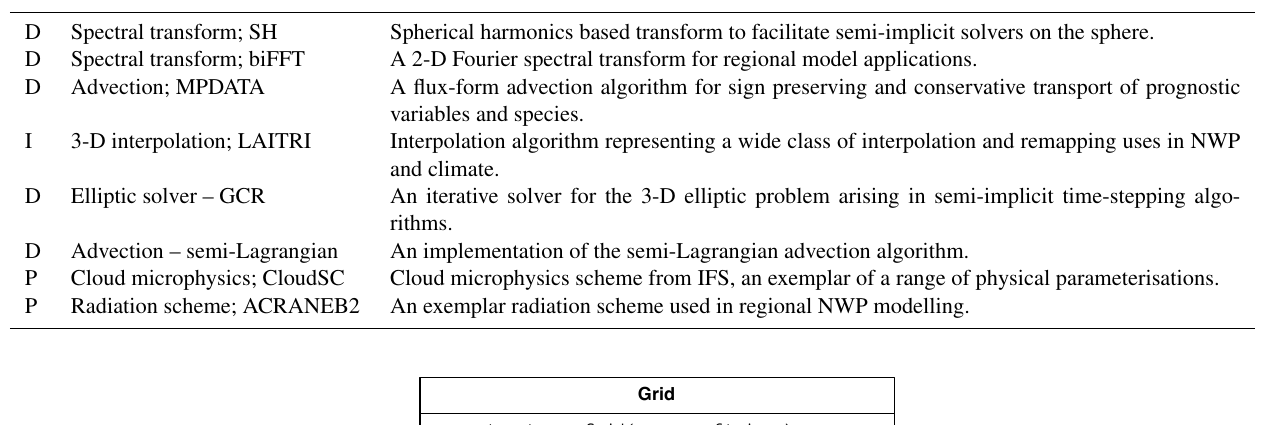
Table 1. The ESCAPE dwarfs – a set of mini-apps providing a sample of characteristic behaviours of weather and climate model subcompo- nents. The “D” category dwarfs are related to the dynamics, the “I” dwarf is general purpose, and the “P” dwarfs represent physics-related issues.